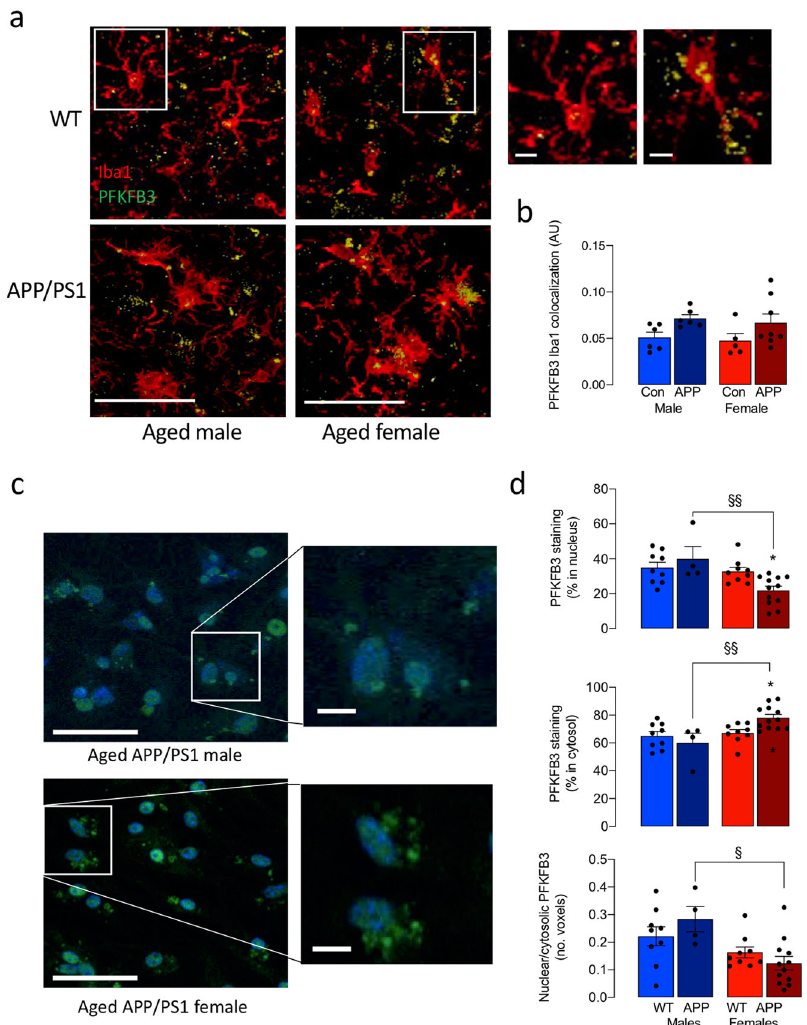
Fig. 5 Cytosolic PFKFB3 is increased in microglia from female APP/PS1 mice. a Representative images of PFKFB3 staining in Iba1 + microglia in sections from the hippocampus. (Scale bar = 100 μ m; magni fi ed image, 20 μ m). b A genotype-related increase in PFKFB3 staining was found in sections prepared from APP/PS1, compared with WT, mice ( p < 0.05; main effect of genotype) though post hoc analysis identi fi ed no signi fi cant changes. Values are presented as means ± SEM ( n = 6 for male WT and APP/PS1 mice, n = 5 and 7 for female WT and APP/PS1 mice, respectively). c Representative images of PFKFB3 staining in isolated microglia. Scale bars: main fi gure, 50 μ m; magni fi ed image, 10 μ m. d The percentage of PFKFB3 staining in the cytosol was signi fi cantly increased while nuclear staining was signi fi cantly decreased in microglia from female APP/PS1 mice compared with male APP/PS1 mice, and the ratio nuclear:cytosolic staining (expressed as voxels) was similarly decreased ( § p < 0.05; §§ p < 0.01; n = 9, 4, 9, 12 for male WT and APP/PS1 and male WT and APP/PS1 mice, respectively). Data, expressed as means ± SEM, were analysed by 2-way ANOVA and Tukey ’ s post hoc multiple comparison